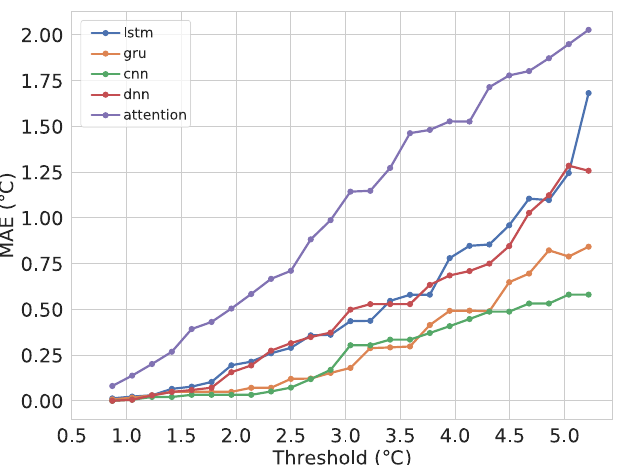
Figure 18. MAE of the predicted time series and real observations per threshold.